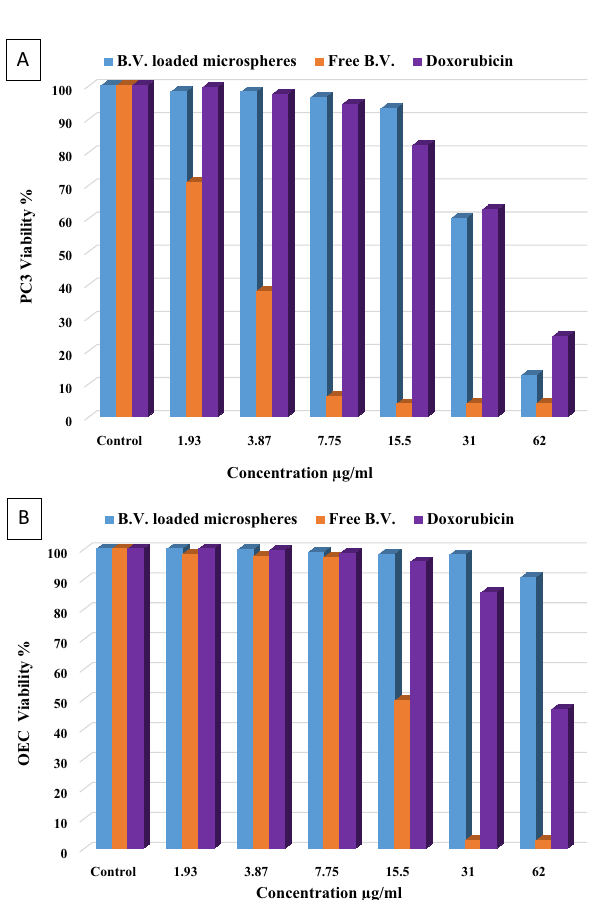
Figure 2. Effect of free B.V., B.V. loaded cross-linked chitosan coated microspheres and doxorubicin on ( A ) PC3 cancer cells ( B ) OEC normal